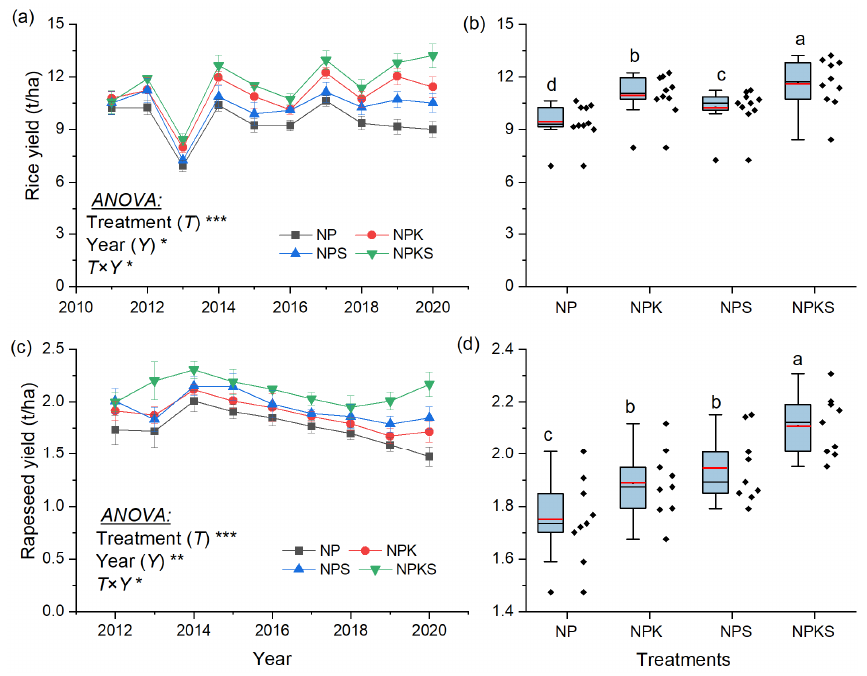
Figure 1. Variation and distribution of grain yields for rice ( a , b ) and oilseed rape ( c , d ) under different fertilization treatments NP, NPK, NPS, and NPKS over 10 years. *, **, and *** indicate significant differences at the p < 0.05, p < 0.01, and p < 0.001 level, respectively in ( a , c ). The upper, middle, and lower limits of each box represent the 75th, 50th, and 25th percentage for crop yield, respectively. Red lines indicate the mean value, and different lower-case letters indicate significant differences for the mean crop yield between treatments at p < 0.05 in ( b , d ).